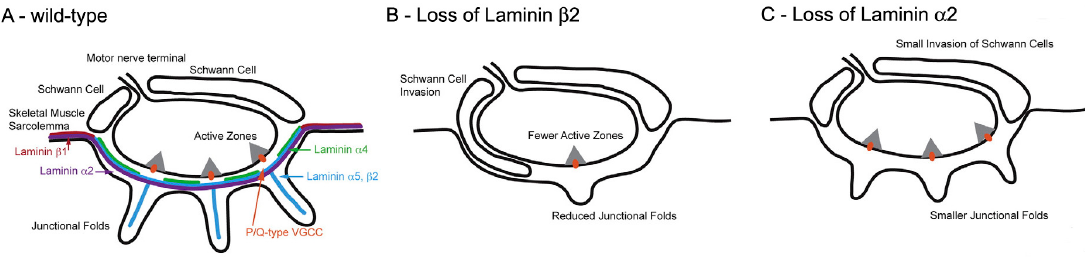
Figure 8. Laminins at the mammalian NMJ. Diagrams of the distribution of various laminin forms at normal and abnormal mouse NMJs. ( A ) Wild type; ( B ) Loss of laminin β 2; ( C ) Loss of laminin α 2. Note that in the absence of laminin β 2, there are almost no folds and the Schwann cell extends into the synaptic cleft. The loss of laminin α 2 causes similar, but less dramatic changes. (Adapted from Rogers and Nishimune, 2016, with permission) [67].